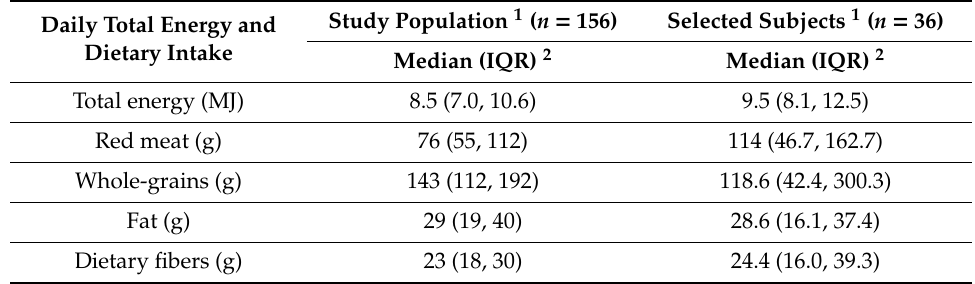
Table 2. The dietary intake of the study population ( n = 156) 1 and the selected subjects for assessment of mucus thickness ( n = 36) 1 .